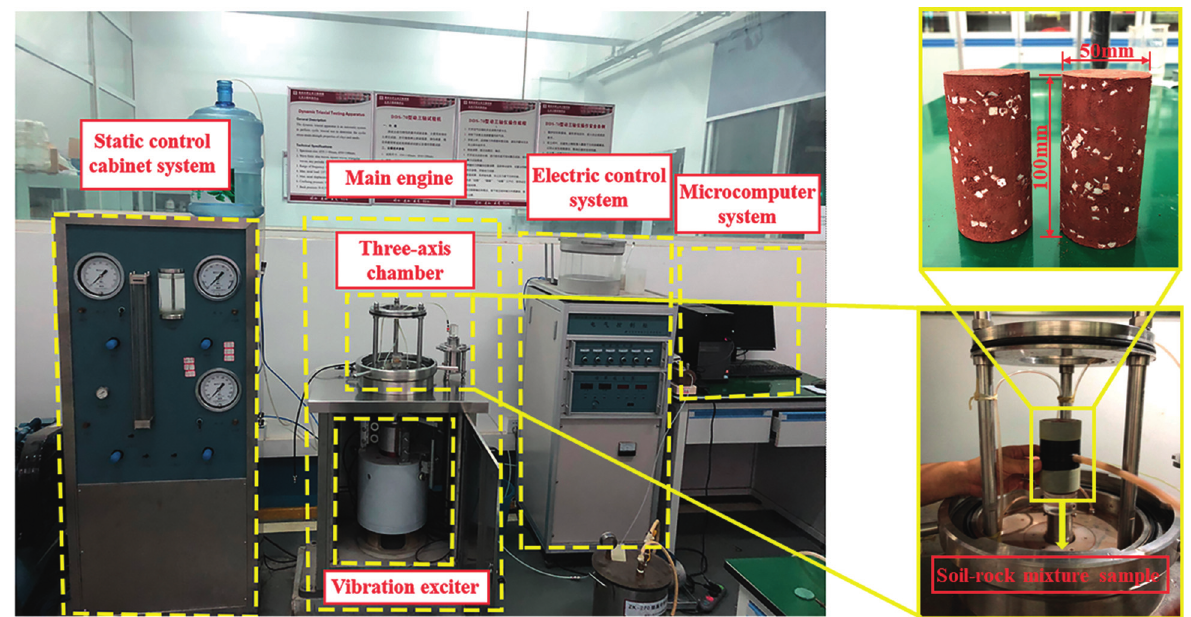
Figure 3: DDS-70 electromagnetic vibration triaxial test system and soil-rock mixture sample.